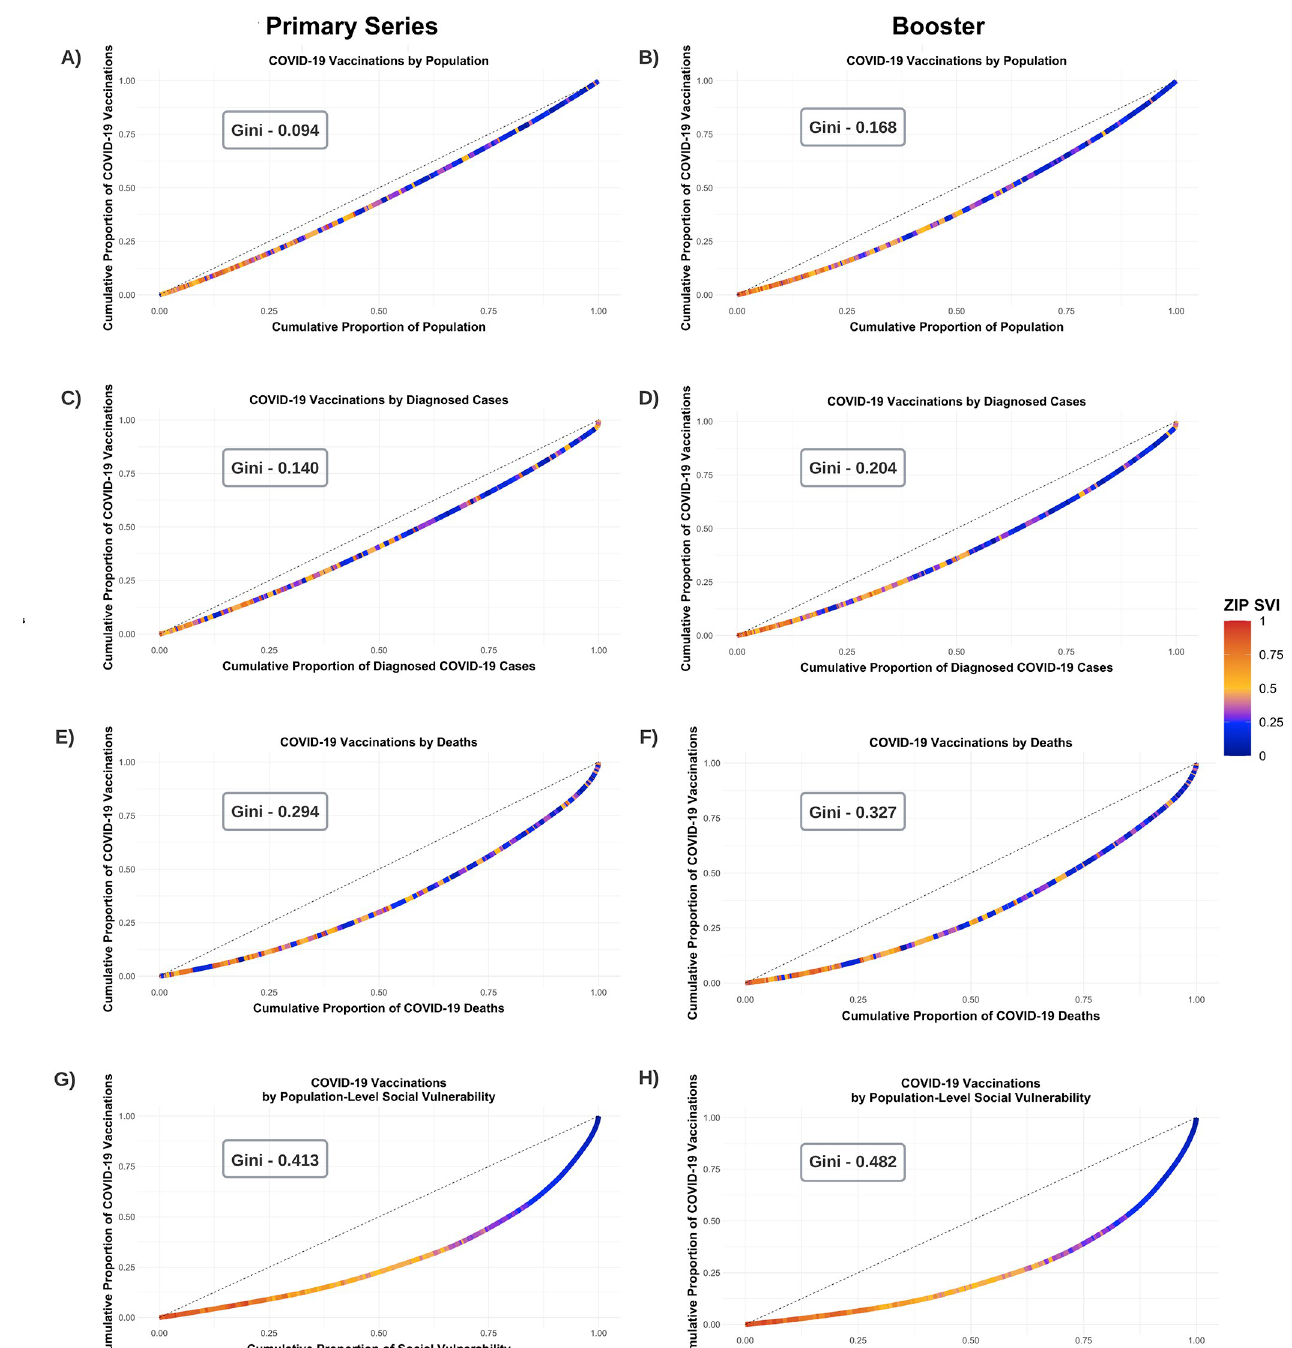
Fig 3. Lorenz curves of disparities in COVID-19 vaccinations. This figure depicts modified Lorenz curves examining disparities in COVID-19 vaccinations as of 15 February 2022. The units of analysis are zip codes, and they are color-coded by their SVI. The dashed line represents equitable distribution, where 50% of vaccinations are distributed in zip codes accounting for 50% of the population, cases, deaths, or total social vulnerability. The Lorenz curves measure disparities in the distribution of receiving the primary vaccine series or a booster relative to the total population aged 12 years or older (A and B), diagnosed COVID-19 cases (C and D), COVID-19 deaths (E and F), and total social vulnerability (G and H). SVI, Social Vulnerability Index.